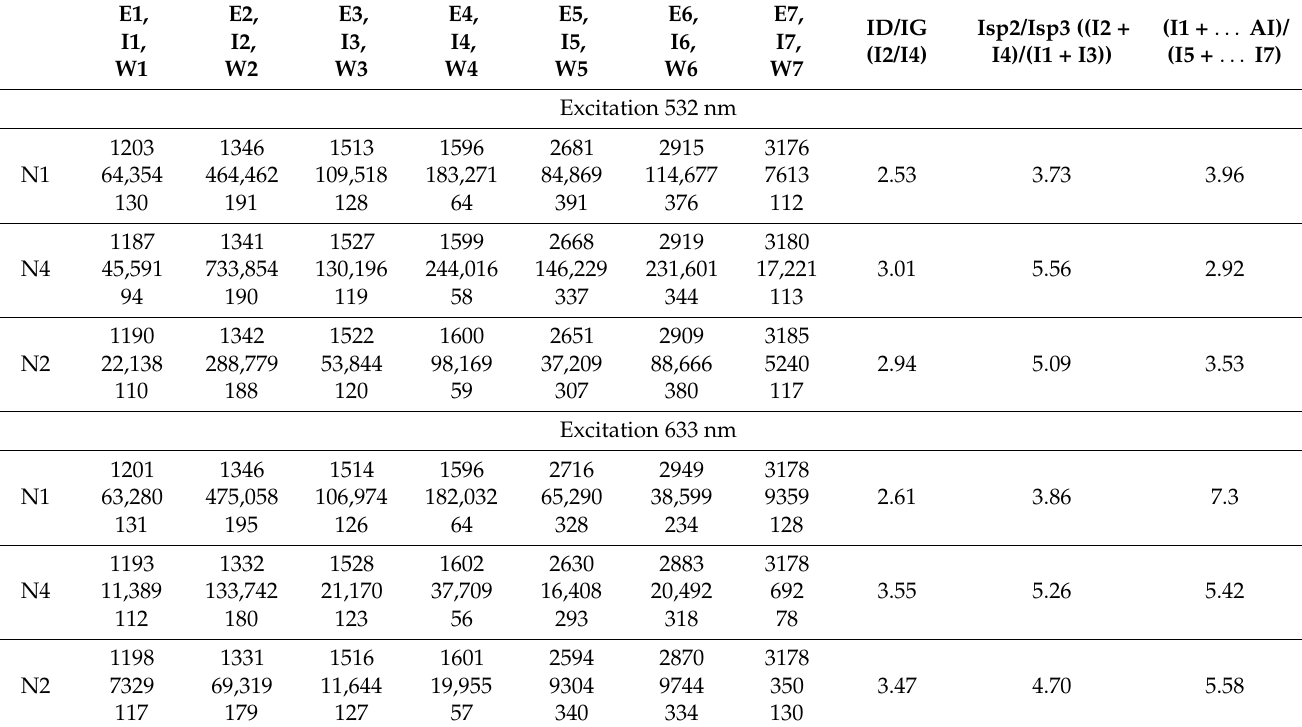
Table 3. The Raman spectra parameters: E1, I1 and W1—position of the maximum, area and width of one Lorentz approximation for the 1st peak and so on for the others shown in Figure 4 for the excitation wavelengths of 532 nm and 633